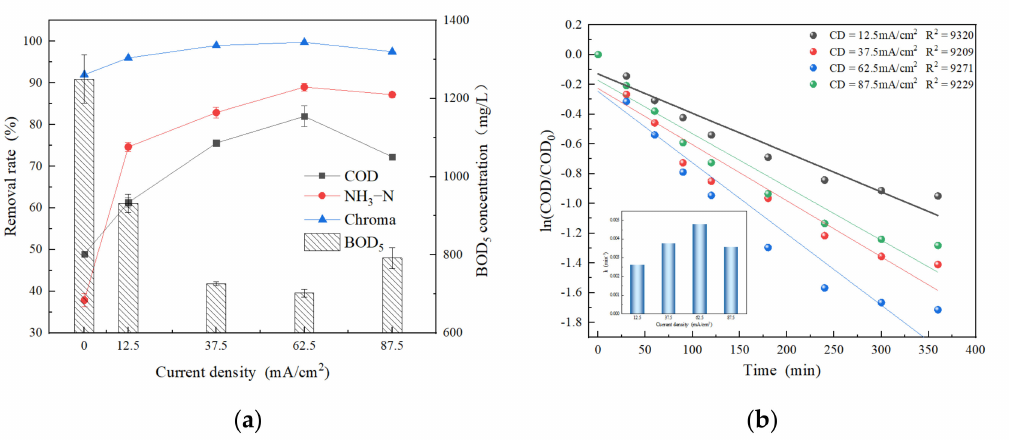
Figure 5. ( a ) Effects of current density on COD, NH 3 -N, chroma removal, and BOD 5 content. ( b ) Pseudo-first-order kinetic models of COD degradation at different current densities. (Initial pH: 3.0; PS/12COD ratio: 1; ZVI dosage: 1.5 g/L; current density: 62.5 mA/cm 2 ; reaction time: 6